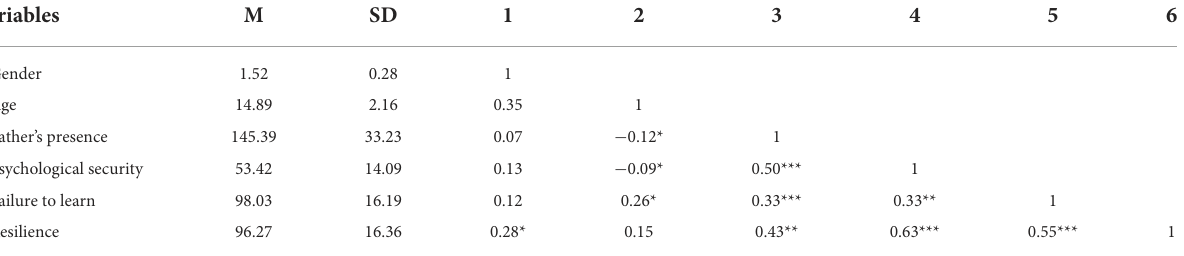
TABLE 1 Descriptive statistics and correlations among study variables ( N =